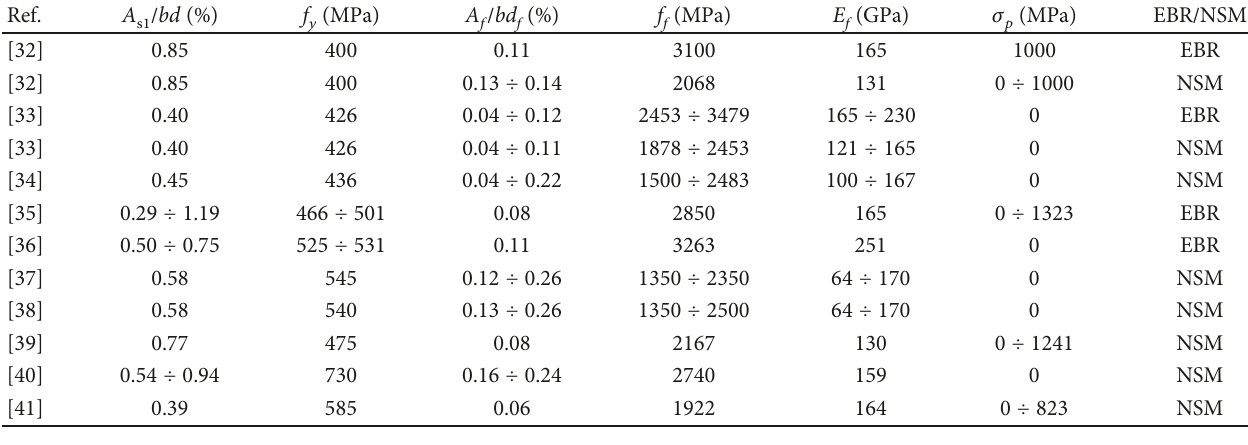
Table 3: Properties of additional beams for load-carrying capacity.